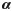
Examples of network Macroscopic Safety Diagram using MFD of Yokohama, Japan for various values of: (a) α; and, (b) β.